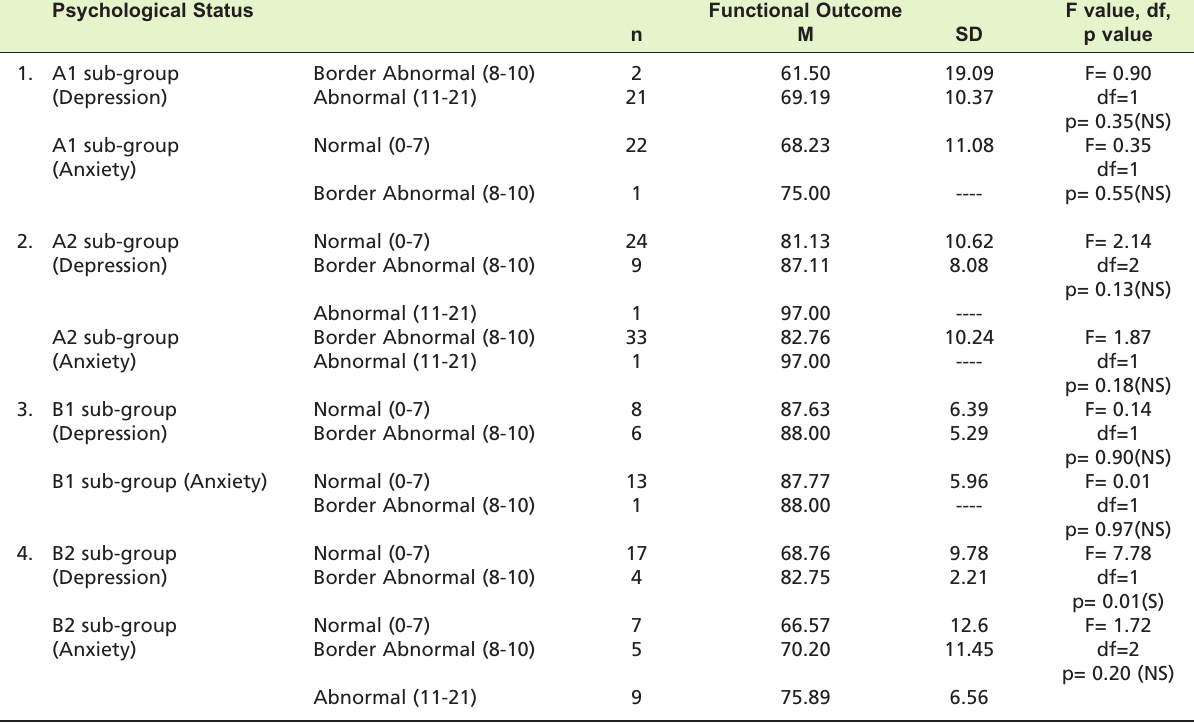
different sub-groups